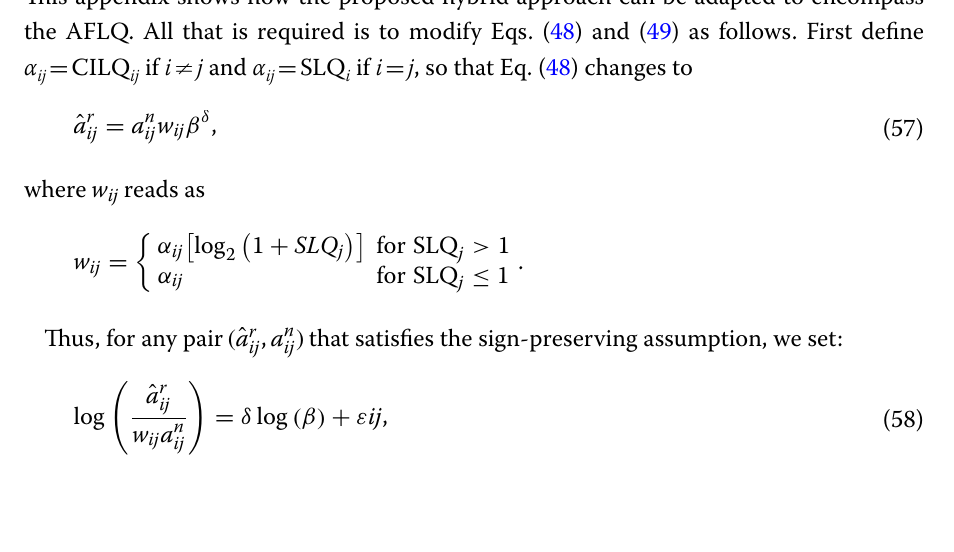
Table 12 Comparison of results for the FLQ and AFLQ in terms of input coefficients. Source: authors’ calculations Region FLQ FLQ AFLQ + MAD Optimal δ MAD Estimated δ MAD Optimal δ MAD Estimated